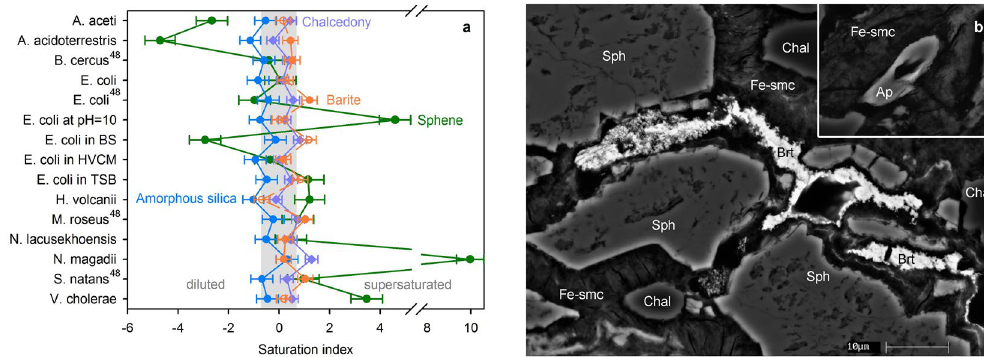
Figure 2. Mineral fingerprints in prokaryotes and minerals precipitated in altered basalts. ( a ) Mineral saturation indices calculated for observed and literature compositions 48 of various prokaryotes at conditions of their cultivation. For a few species, barite saturation indices (unfilled circles) were estimated using the median valuve of sulfur measured in other species. The shaded region approximates the equilibrium range. Uncertainties are 2 σ . ( b ) An analogue for the cradle environment in the modern weathering regolith of Paraná basalts. Mineral abbreviations: Ap – apatite, Brt – barite, Chal – chalcedony, Fe-smc – Fe-smectite, Sph –